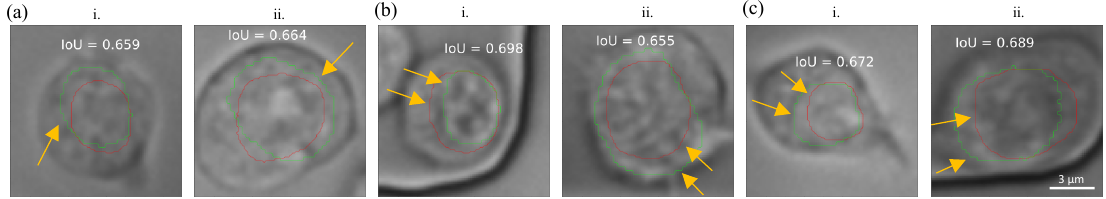
Figure 8. Representative examples of errors in the mask due to ( a ) ambiguous boundaries, ( b ) mismatched size or ( c ) shifted boundaries. Green lines and red lines denote masks from experts and Mask RCNN,